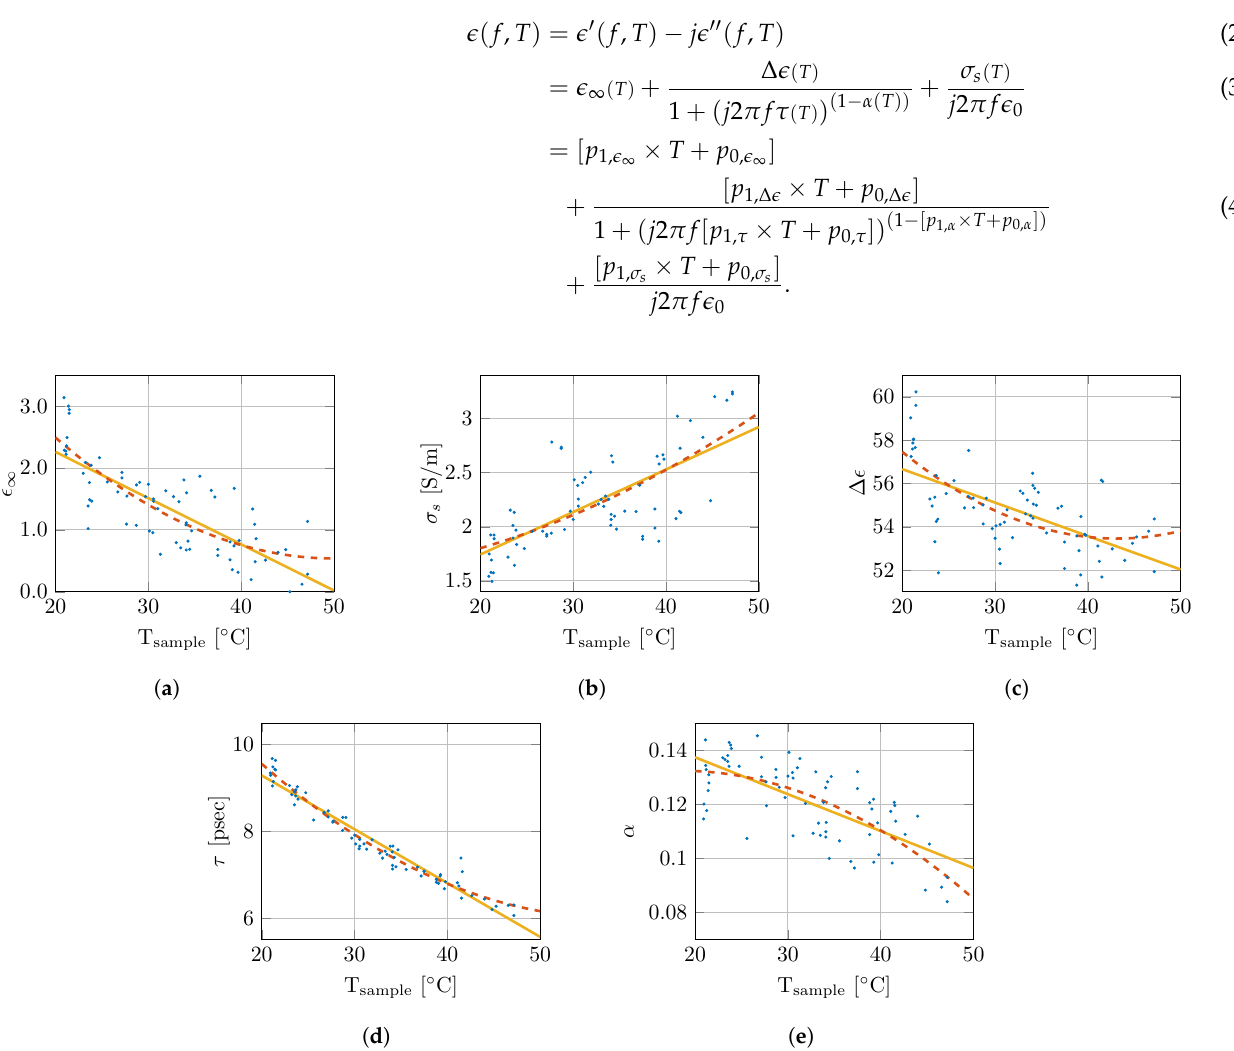
Figure 6. Overview of change in Cole–Cole parameters in function of sample temperature with a first ( ) and second ( ) order polynomial fit. The Cole–Cole parameters (cid:101) ∞ , σ s , ∆ (cid:101) , τ , and α are shown in ( a ), ( b ), ( c ), ( d ) and ( e ),